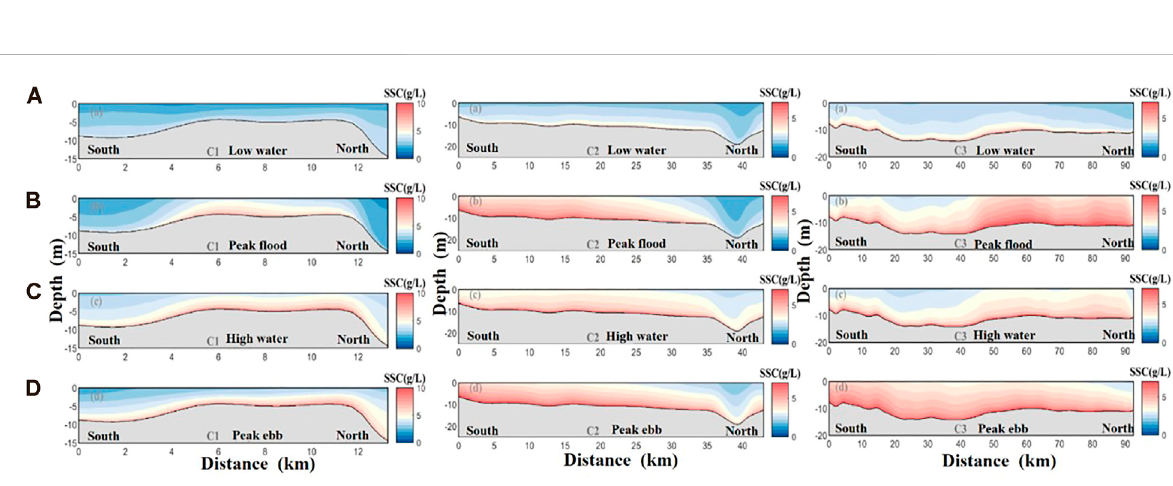
Frontiers in Earth